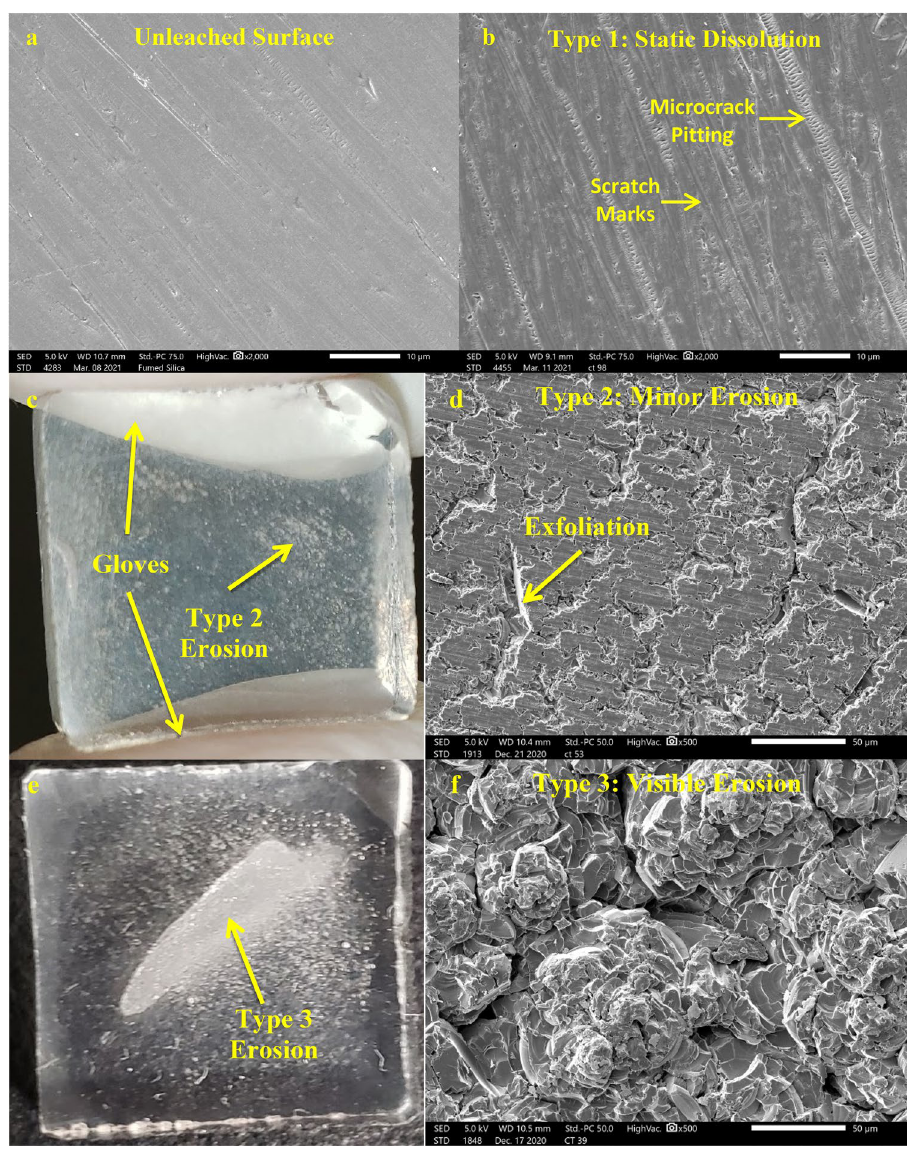
Figure 2. Microscopy of unleached and leached surfaces. Unleached glass surface ( a ) at 2000 × showing scratch marks and light microcrack pitting present. Type 1/static dissolution surface at 2000 × ( b ) using a micrograph from a 7.5 h experiment. These regions show preferential dissolution of scratch marks and microcracks. Type 2 surface features at a macroscopic ( c ) and 500 × ( d ) view taken from a from a 20 W cm −2 , 7.5 h experiment. Surface characterized by exfoliation of the glass surface around areas of leached scratch marks. Type 3 surface features at a macroscopic ( e ) and 500 × ( f ) view taken from a 10 W cm −2 , 1 h experiment. Surfaces are characterized by heavy erosion that has completely altered the morphology resulting in significant roughening. The glass is visibly opaque in these